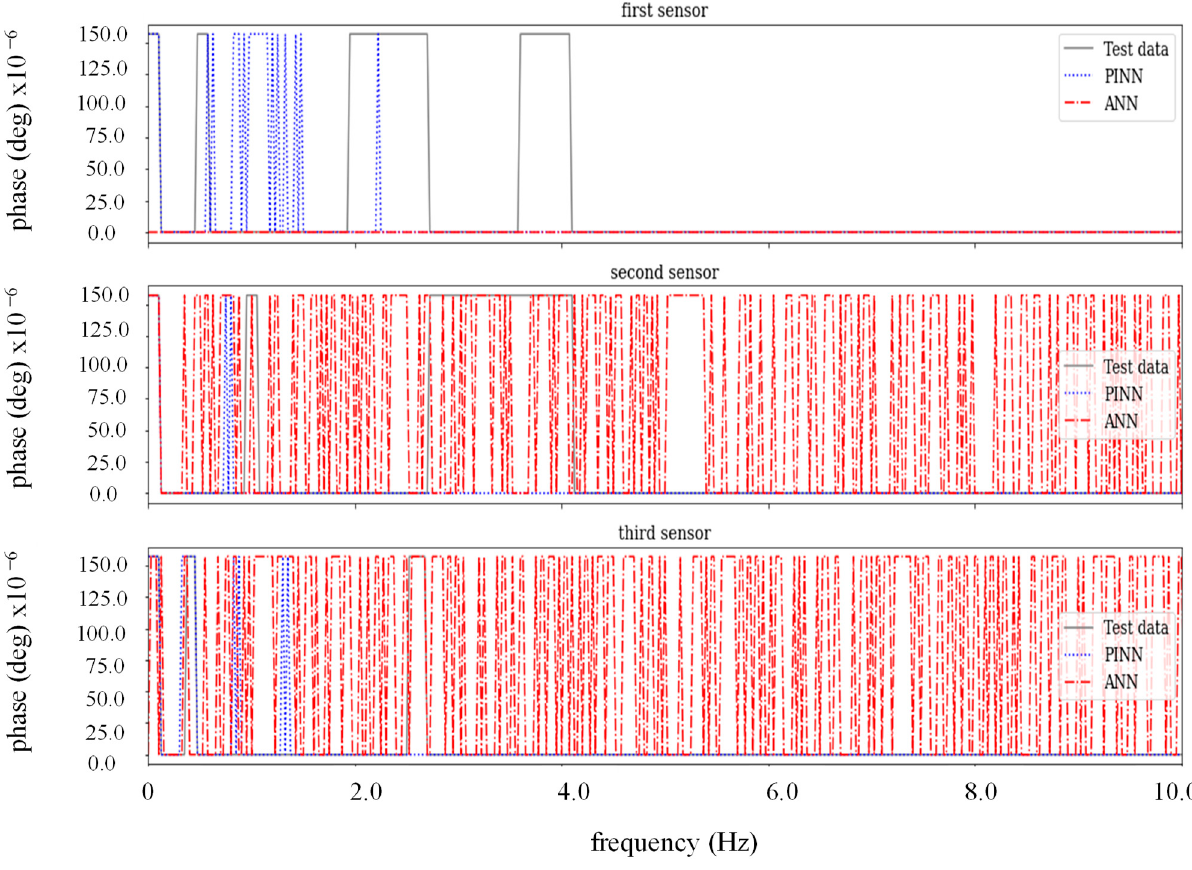
Figure 22. PINN and ANN phase lag of each sensor with two hidden layers for the test period.